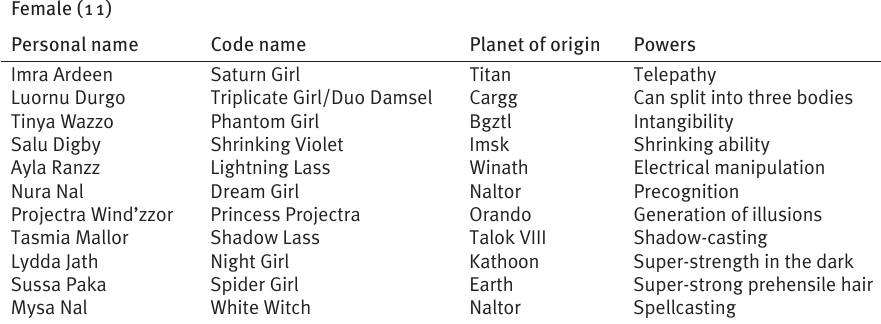
TABLE 2 FEMALE SILVER AGE MEMBERS OF THE LEGION OF